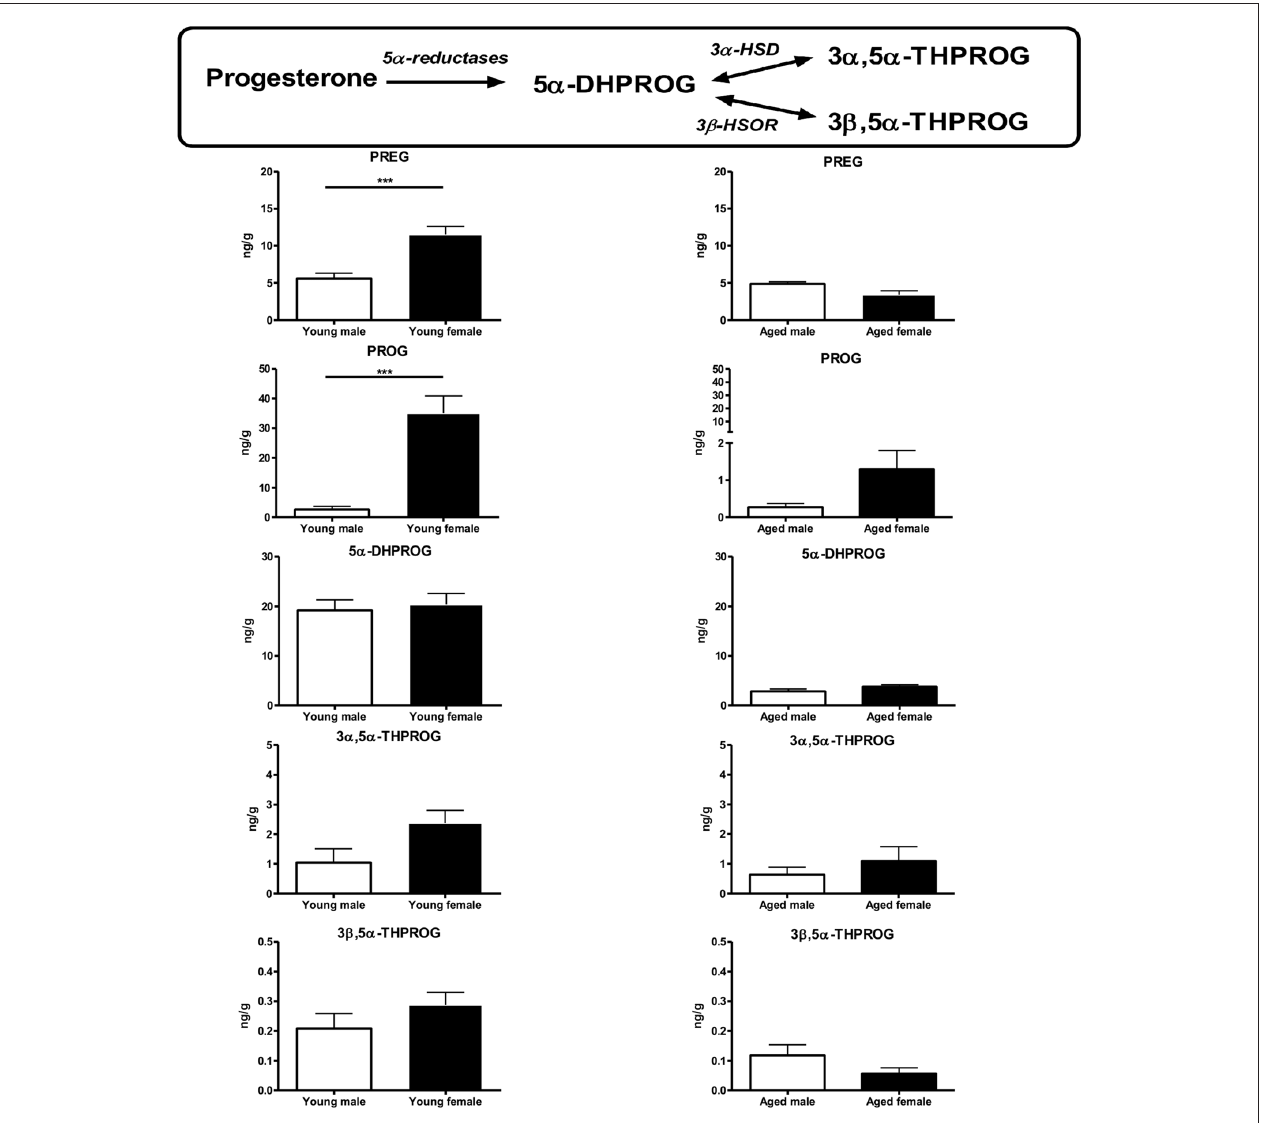
FIGURE 5 | Brain levels of progesterone and its metabolites in young (3-month-old) and aged (20-month-old) male and female mice. Young females (diestrus stage) had higher brain levels of pregnenolone and progesterone when compared to young males. These differences disappeared in aged mice. The levels of 5 α -reduced metabolites were not statistically different between sexes in young or aged mice. Data represent mean ± SEM of 4–6 mice. Statistical analysis: t -test. Significance: ∗∗∗ p < 0.001. 3 α -HSD, 3 α -hydroxysteroid dehydrogenase; 3 β -HSOR, 3 β -hydroxysteroid oxidoreductase; 5 α -DHPROG, 5 α -dihydroprogesterone; 3 α ,5 α -THPROG, 3 α ,5 α -tetrahydroprogesterone or allopregnanolone; 3 β ,5 α -THPROG, 3 β ,5 α -tetrahydroprogesterone or iso-allopregnanolone; PREG, pregnenolone; PROG, progesterone. Data from Gaignard et al.